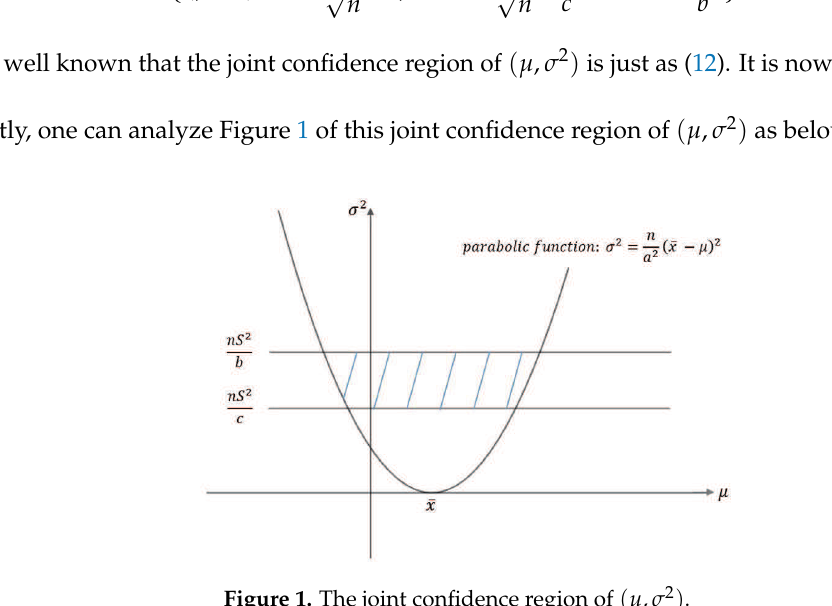
Figure 1. The joint confidence region of ( µ , σ 2 )